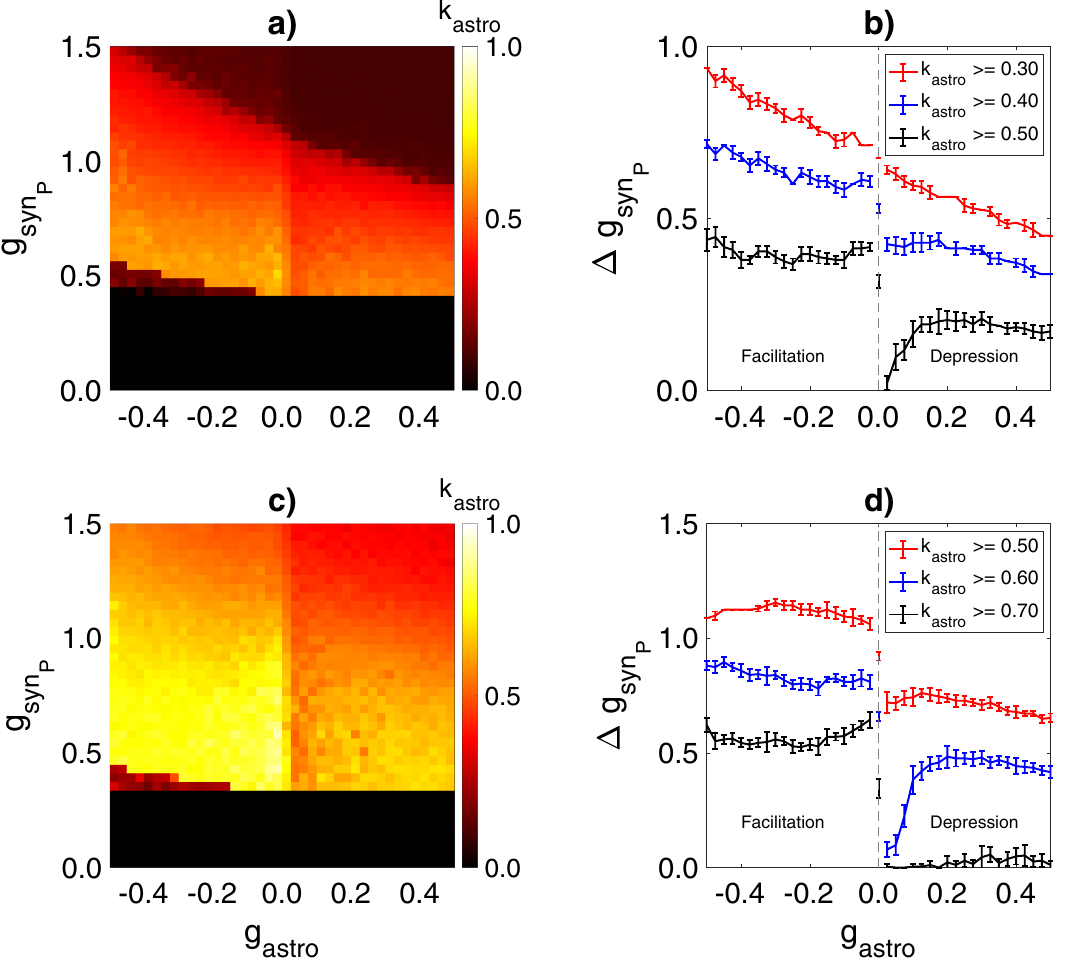
Figure 7. ( a , c ) Mean network coherence during the astrocytic regulation of synaptic transmission, k astro , is plotted against the strength of the excitatory synaptic transmission ( g syn modulation of the excitatory synaptic weights ( g astro ). ( b , d ) Dependence of the g syn to the different coherence levels on the astrocytic modulation strength, g astro . Each point represents an average ± standard deviation over 10 simulations. ( a , b ) g syn = 0.01 mS/cm 2 , ( c , d ) g syn = 0.017 mS/cm 2